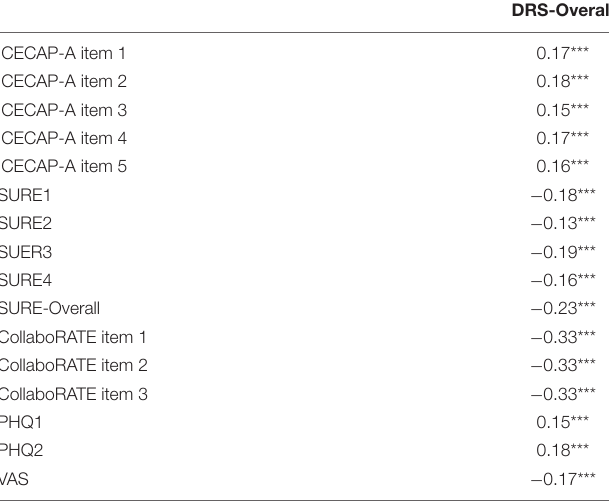
TABLE 5 | The correlation between DRSc and the other measures.